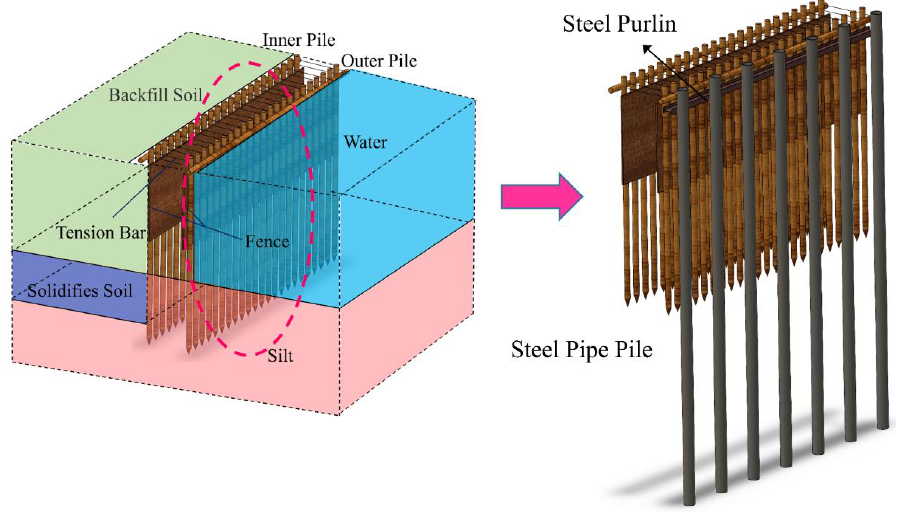
Figure 24. Steel pipe pile reinforced cofferdam structure.